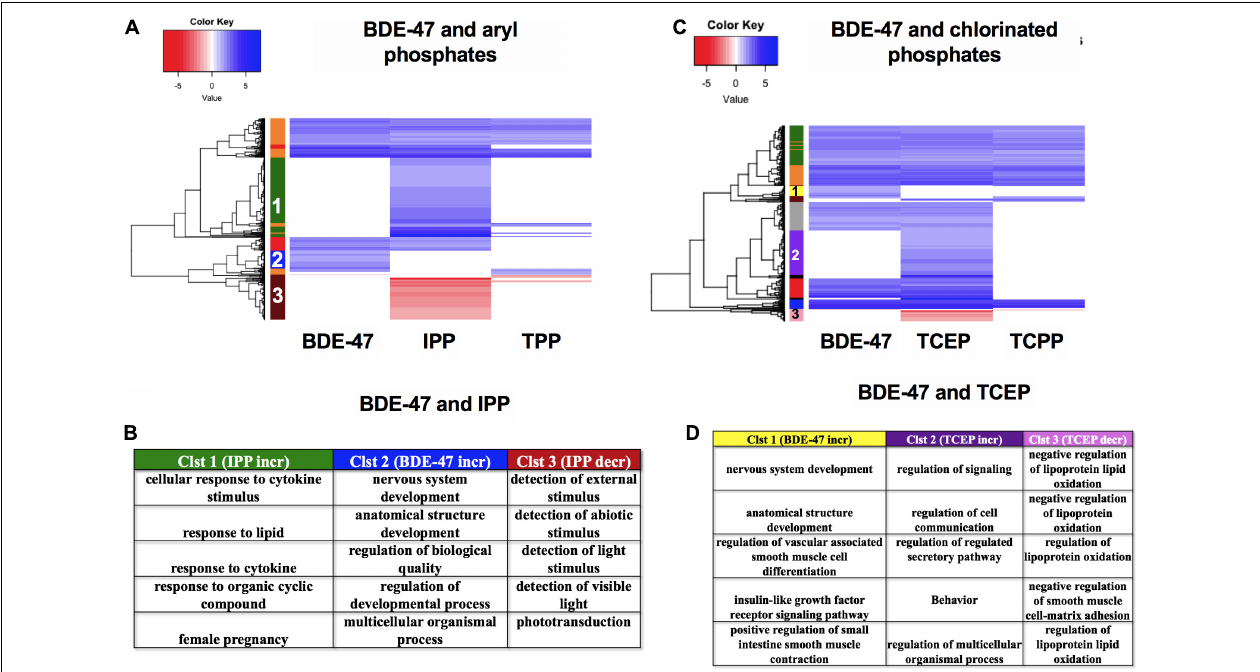
FIGURE 10 | mRNA expression for BDE-47, aryl phosphates and chlorinated phosphates. (A,C) Heatmaps representing log 2 fold changes of mRNA expression; colored bars on the rows represent mRNA clusters. Numbers within bars represent cluster numbers for specific mRNA sets. (B,D) GO processes for unique mRNAs that were increased or decreased uniquely in various